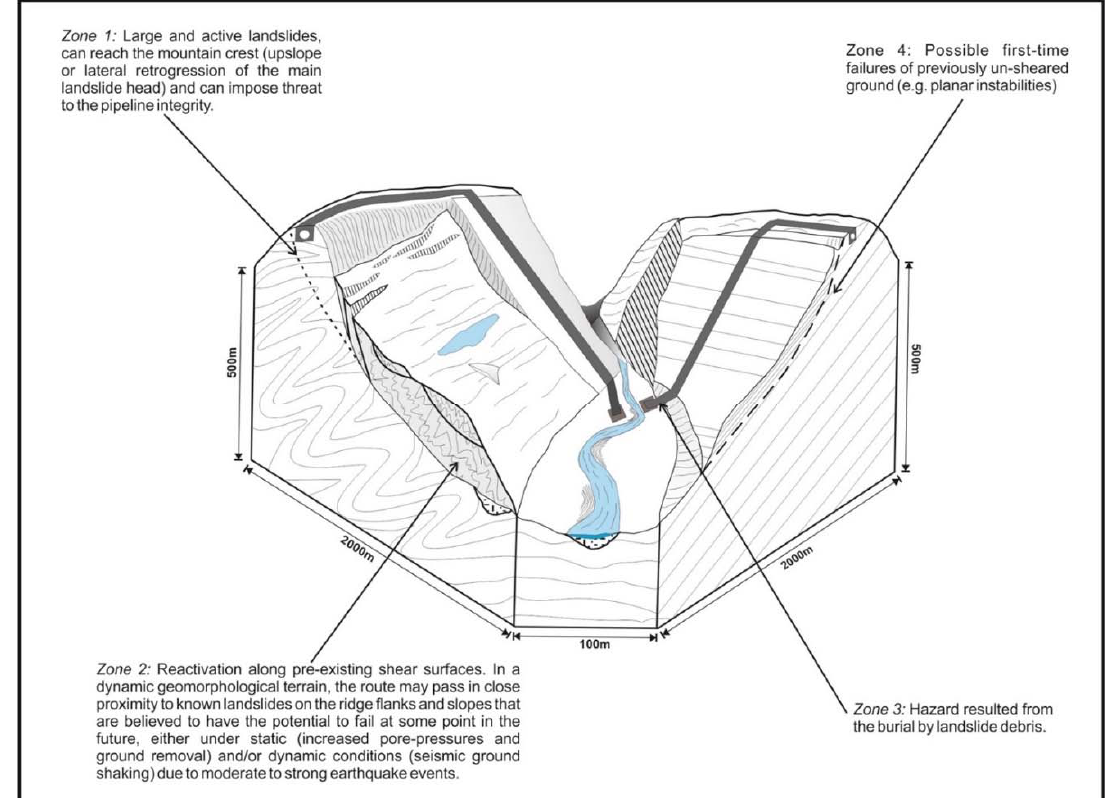
Figure 4. Possible failure event scenarios associated with pipeline rupture.